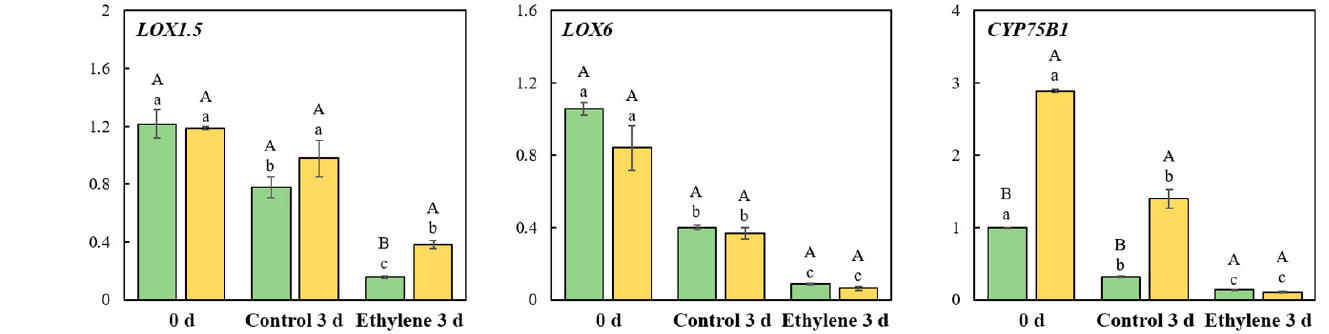
Figure 7. qRT-PCR transcript accumulation of the selected DEGs of green ‘Hayward’ and gold ‘Haegeum’ kiwifruit for the comparison of fruit on day 0 and third day of ripening at 25 ◦ C with ethylene treatment or without treatment (control). Vertical bars represent standard errors of the means ( n = 3). The bars with different upper-case letters indicate a significant difference ( p < 0.05) between cultivars, whereas the bars with different lower-case letters indicate a significant differ- ence ( p < 0.05) between treatments. The names of genes are indicated: EXPA8 (expansin-A8-like) ,